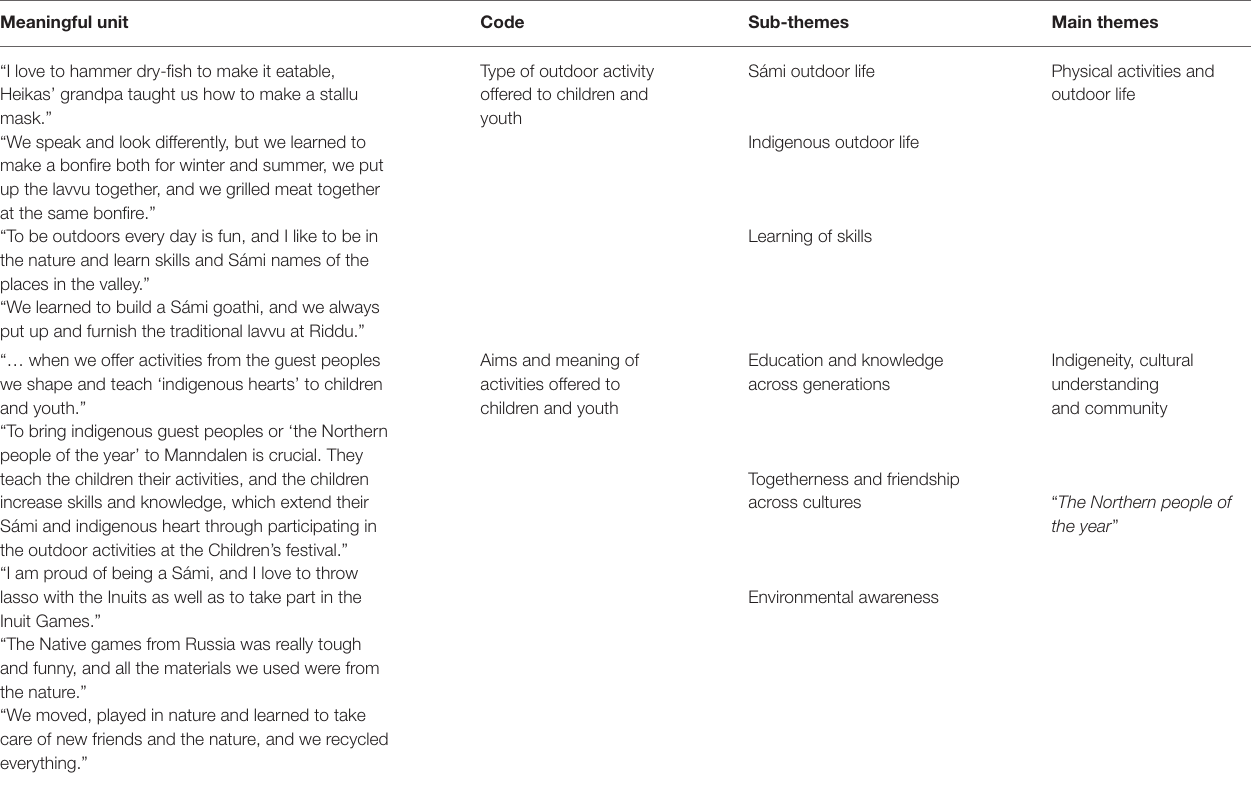
TABLE 1 | Examples of the analysis process. Meaningful